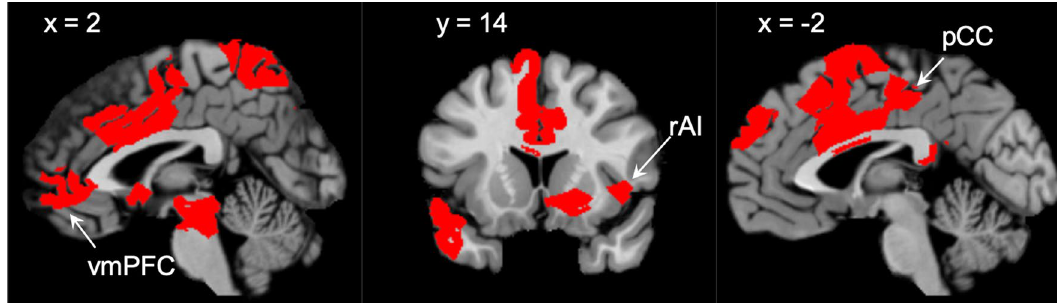
Figure 7. Nodes, or regions, with the highest number of connections in the brain-behavior model include members of both default mode (vmPFC and pCC) and salience (rfO/raI) networks. Edges thresholded at p =